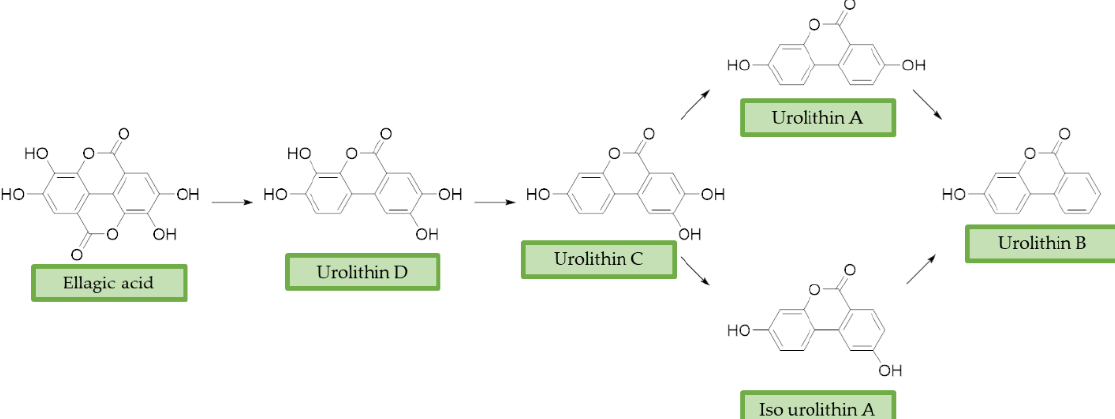
Figure 3. Ellagic acid (EA) and its urolithins metabolites after gut microbiota metabolism. Briefly, after intestinal uptake the hydrolysis and subsequent decarboxylation of EA’s lactone generates urolithin D (UD), that provides UC losing a hydroxyl group. Then, the removal of a phenolic group in 9 or 8 position affords UA or iso-UA, respectively. Finally, UB is produced by removal of the phenolic group in 8 or 9.